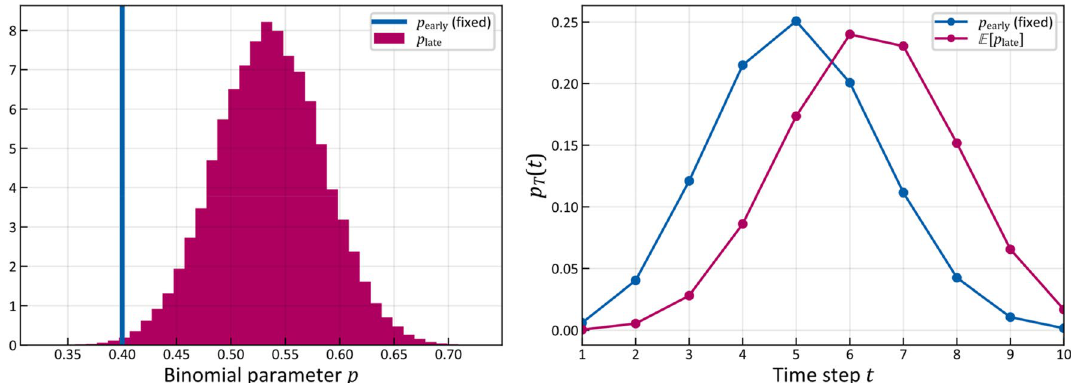
Figure 10. Sampled late T-category p parameter given an early T-category cohort and a fixed fraction of N 0 patients (20%) for late T-category (left). Plots of the PMFs of the fixed early T-category Binomial distribution and the distribution for the expected value of the late T-category parameter (right).